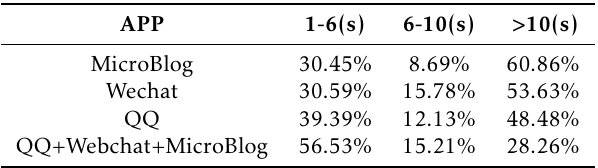
Table 1. Time distribution of the interval between the packet’s